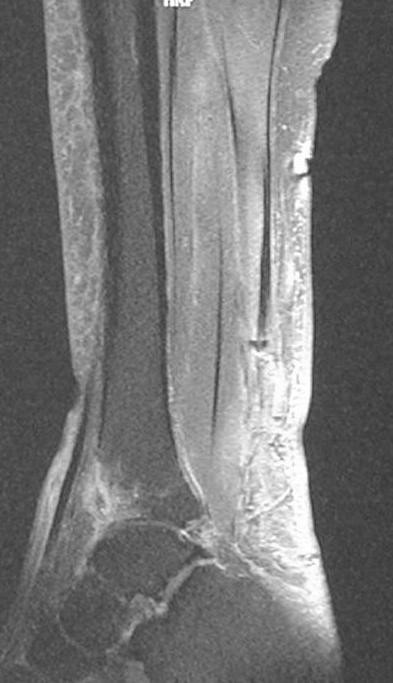
MRI scan one week after open repair of the Achilles tendon. Note the dishomogeneous signal from the repaired Achilles tendon and the bone bruise